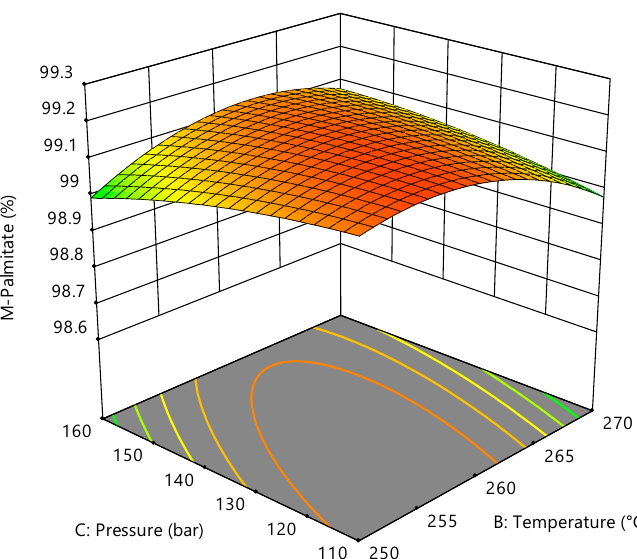
Figure A7. Response surface and contour plot for the effect of reaction temperature and pressure on the yield of methyl-palmitate.